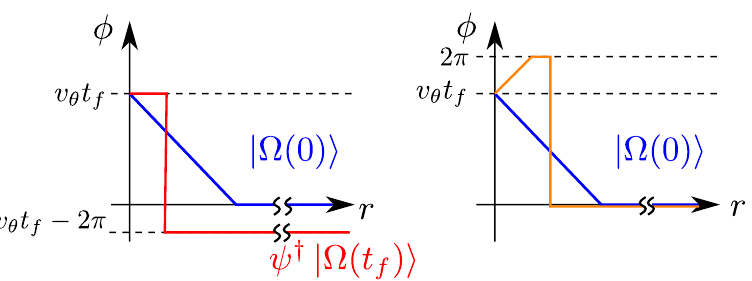
Figure 2 . The profile of φ . The blue line corresponds to the vacuum | Ω(0) i at t = 0 . The red line corresponds to the one-particle state ψ † | Ω( t f ) i at t = t f . In the bosonized theory, the local creation of a fermion corresponds to the insertion of a sharp kink. Due to the large misalignment between the two profiles, the states are orthogonal to each other in L → ∞ limit. The orange line represents an example of the profiles that can be regarded as a one-particle state locally and have a finite overlap with | Ω(0) i